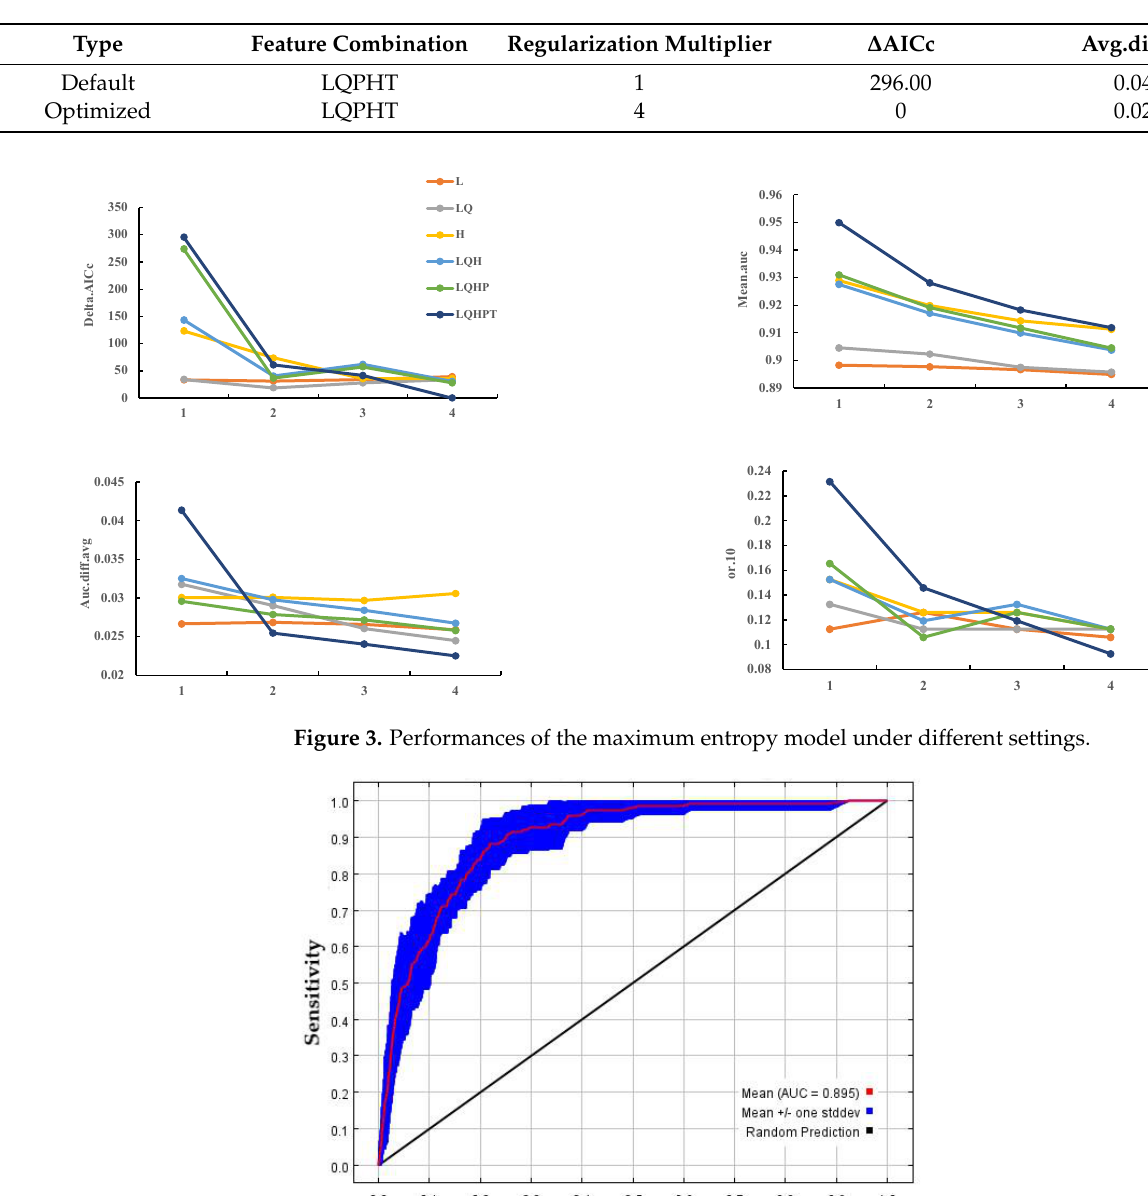
Table 2. Evaluation metrics of MaxEnt model generated by Enmeval.